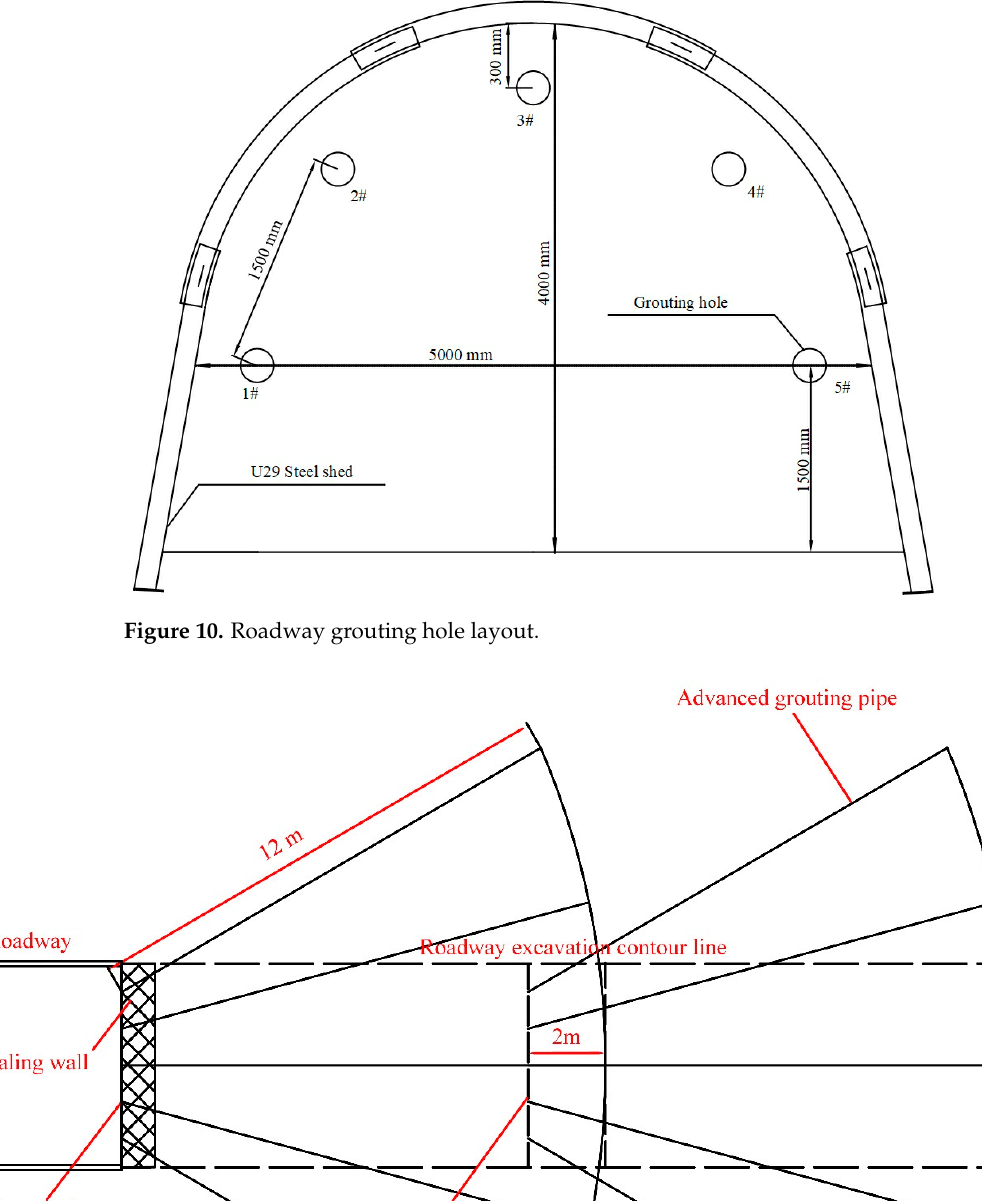
( b ) Transversal section Figure 11. Schematic diagram of advanced grouting construction. ii.